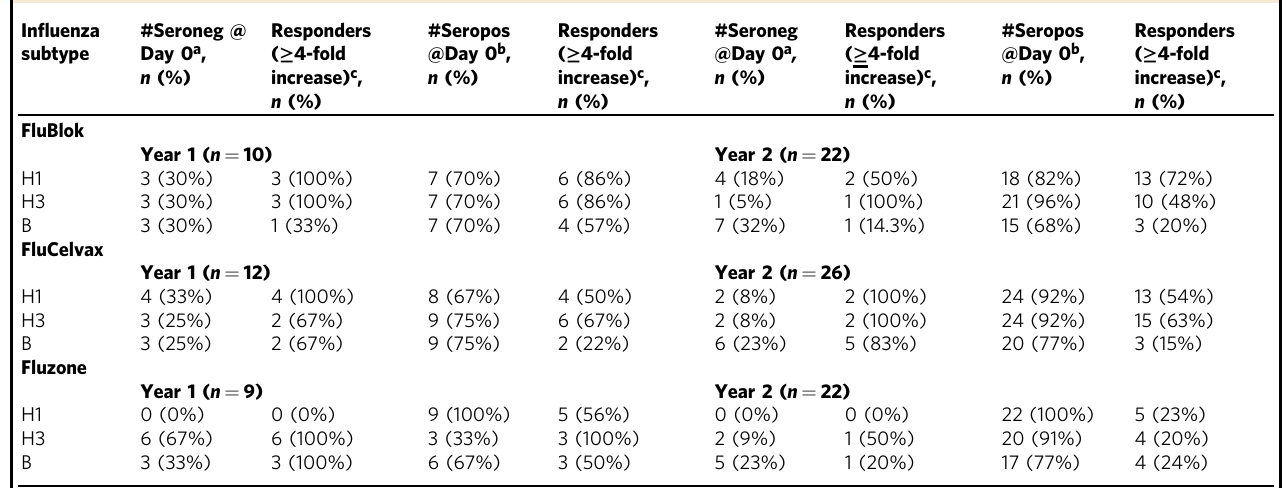
Table 1 Distribution of subjects and frequency of responders in this study In fl uenza